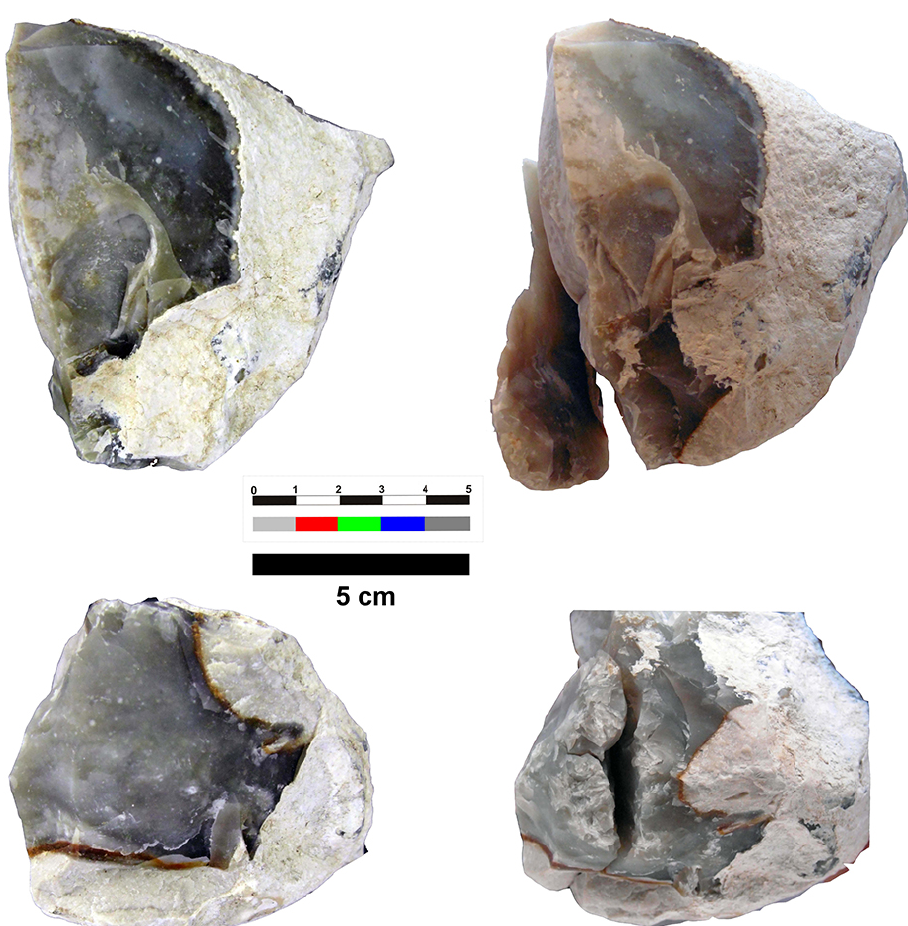
Figure 6. Example of experimentally broken hammerstones. The break has produced a flake. This flake presents a striking platform composed of numerous previous strikes or